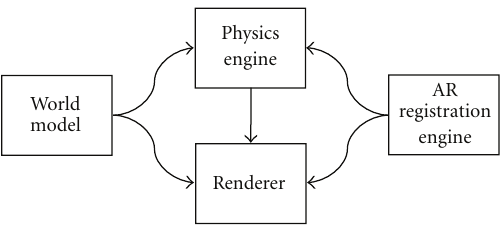
Figure 1: The components of the Motion in Augmented Reality Games engine.